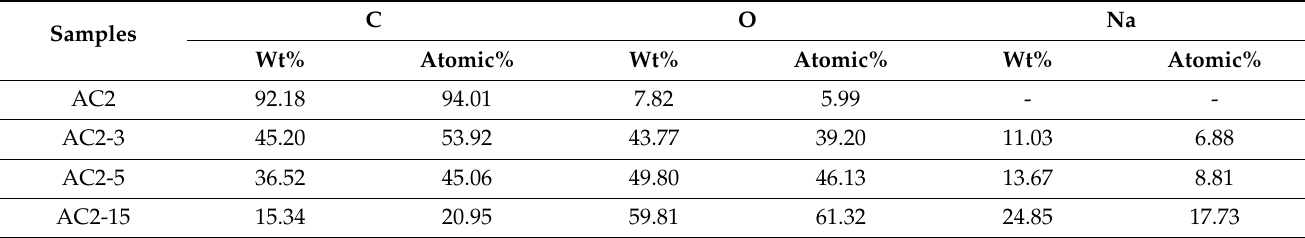
Figure 2. SEM images of coconut-shell activated carbon (AC2) impregnated with NaOH solutions of varying concentrations. Table 3. Elemental compositions of NaOH impregnated activated carbons obtained from SEM-EDX (Scanning Electron Microscopy with Energy Dispersive X-Ray)